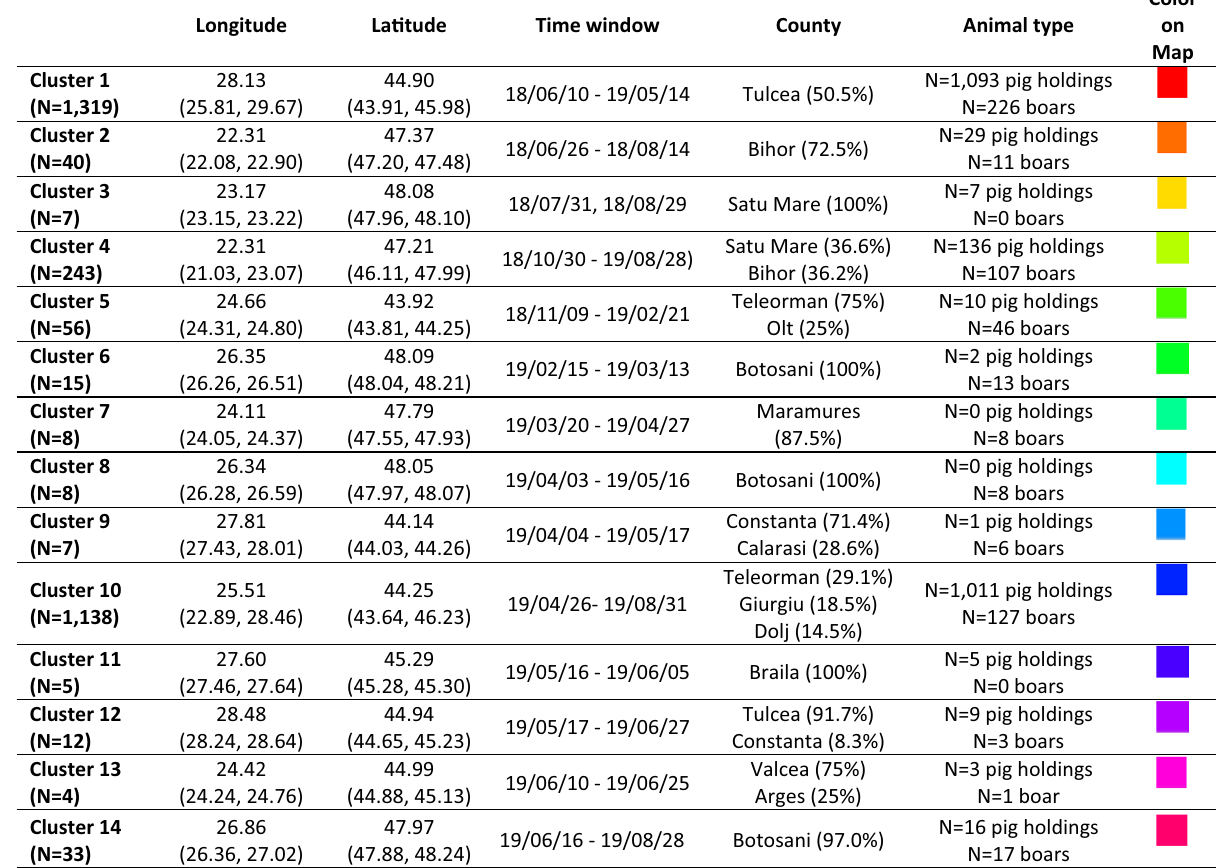
Table 1. Description of the 14 spatiotemporal clusters of ASF in Romania from June 10, 2018 to August 29, 2019 (N = 2973 cases; 2371 pig holding outbreaks, 602 wild boar cases), given in chronological order. Mean values, minimum and maximum (bracketed) values for longitudinal and latitudinal expansion. The counties in which the majority of cases for each cluster is given along with the percentage of cases in these counties. The colors correspond to the ellipsoids in Fig. 5.